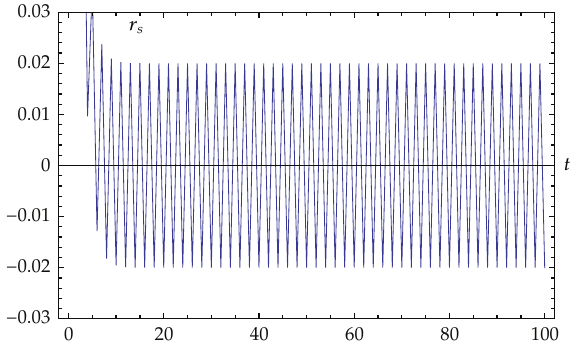
Figure 5: Trajectory of expected return r s when χ 1 (cid:7) − 4.